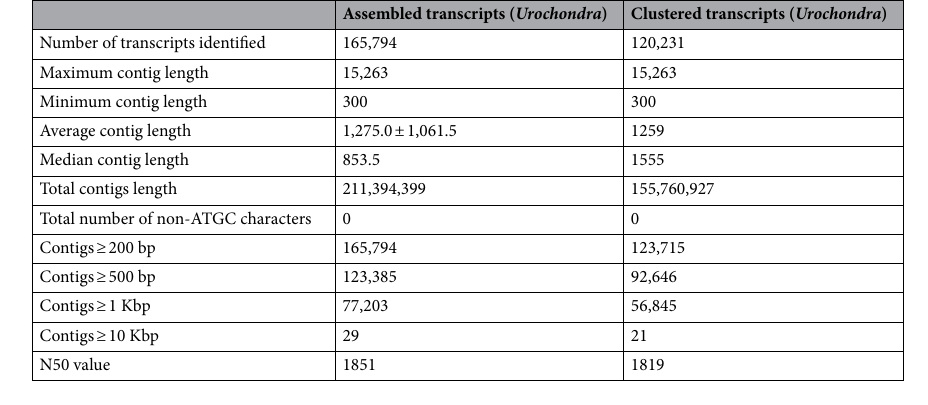
Table 1. Assembly Statistics of unigenes in Urochondra